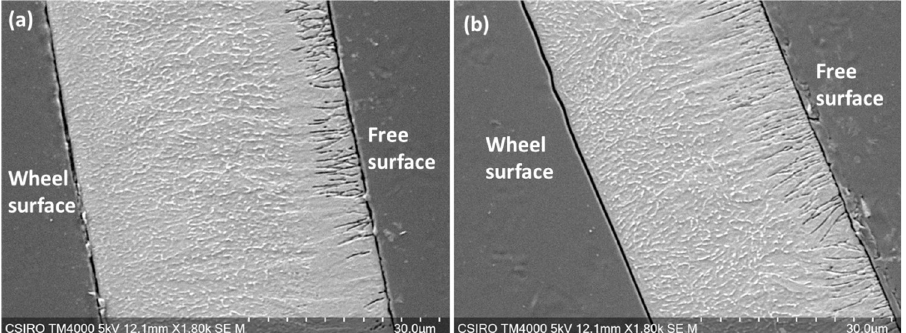
Fig 2. SEM micrograph of the cross section of the etched (a) as cast and (b) 550˚C heat treated NiTi